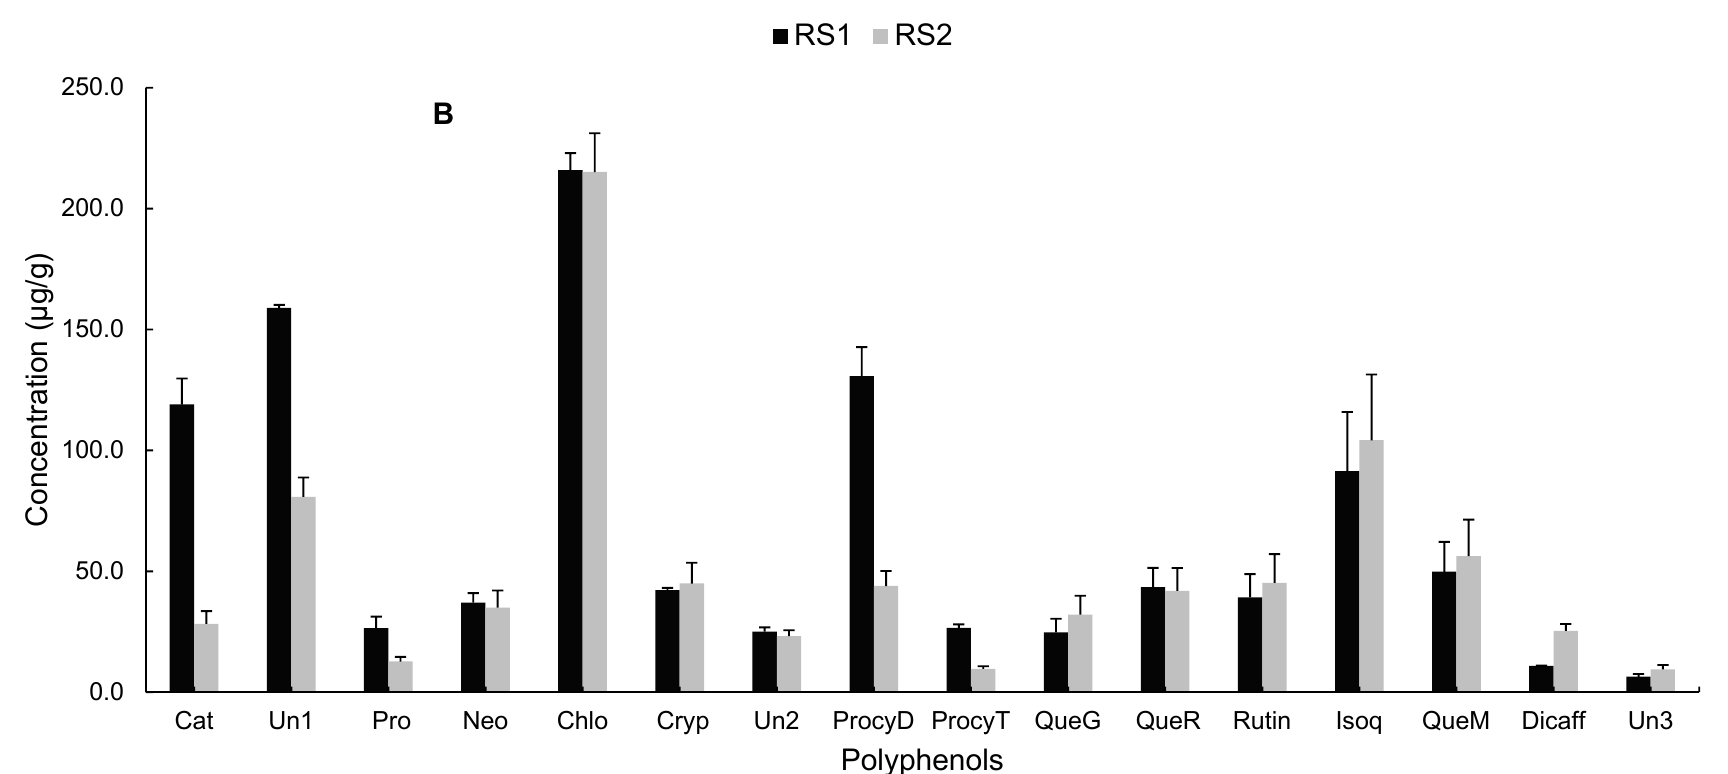
Figure 5. Compounds present in Carissa edulis fruit. ( A ) Identified compounds in C. edulis fruit; ( B ) polyphenolic content of Carissa edulis fruit. RS1, first stage of ripening of C. edulis ; RS2, second stage of ripening of C. edulis berries; QA, quinic acid; CA, citric acid; Cat, catechin; Un1, unknown compound 1; Pro, protocatechuoyl-hexose; Neo, neochlorogenic acid; Chlo, chlorogenic acid; Cryp, cryptochlorogenic acid; Un2, unknown compound 2; ProcyD, procyanidin dimer; ProcyT, procyanidin trimer; QueG, quercetin-3- O -glucosyl xyloside; QueR, quercetin-3- O -robinobioside; Isoq, isoquercitrin (quercetin-3- O -glucoside); QueM, quercetin-3-OH-3-methylglutaryl-glucoside; Dicaff, dicaffeoylquinic acid; and Un3, unknown compound 3. Error bars are standard deviation of mean values ( n = 3).